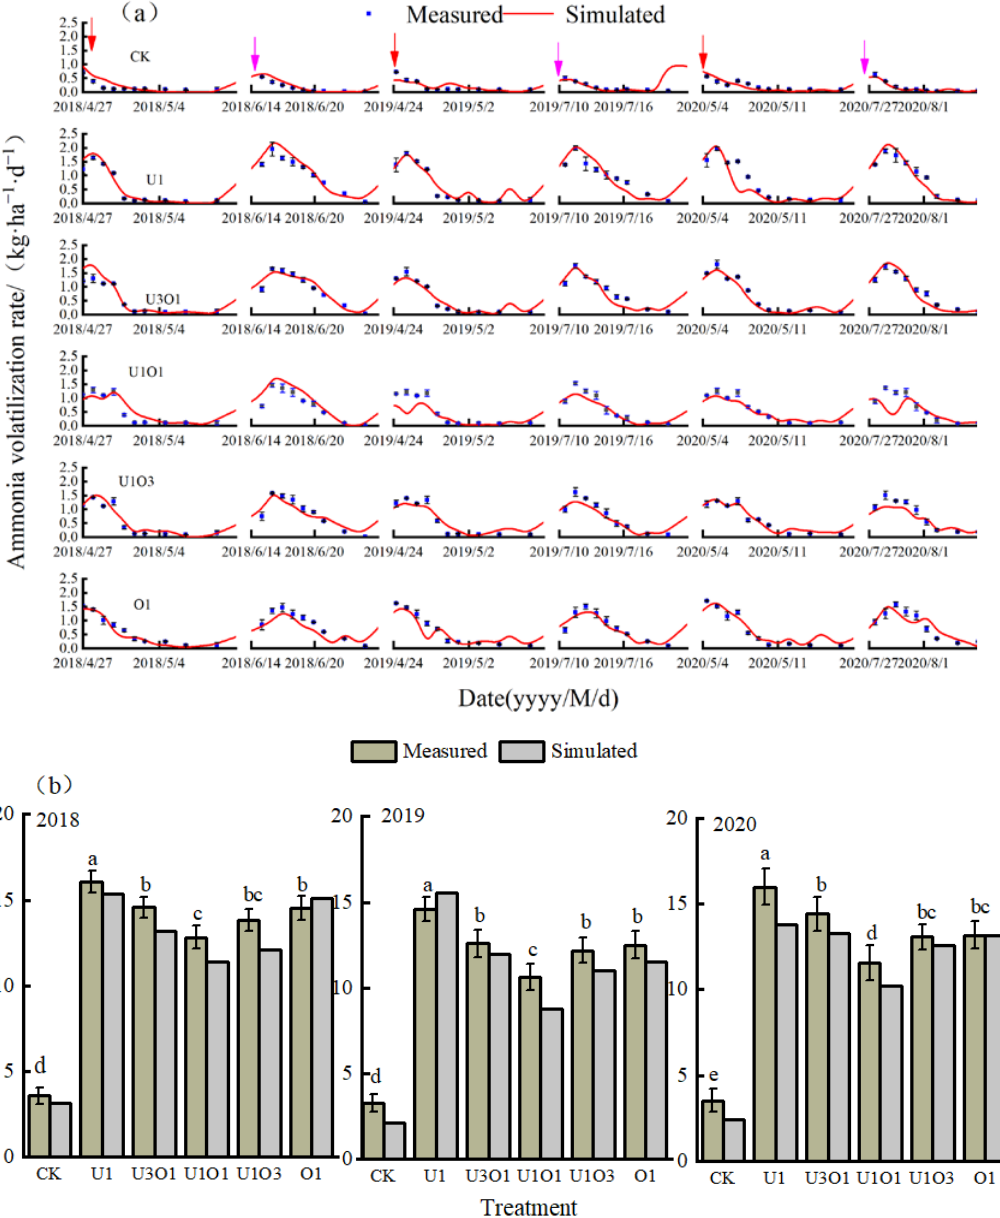
Figure 4. Simulated and measured values of soil ammonia volatilization rate ( a ) and cumulative emissions ( b ). Note: red and pink arrows indicate basal dressing and topdressing events, respectively. The measured data are the means of three replicates, and vertical bars indicate standard errors of replicates. Different small letters indicate significant differences ( p < 0.05) between